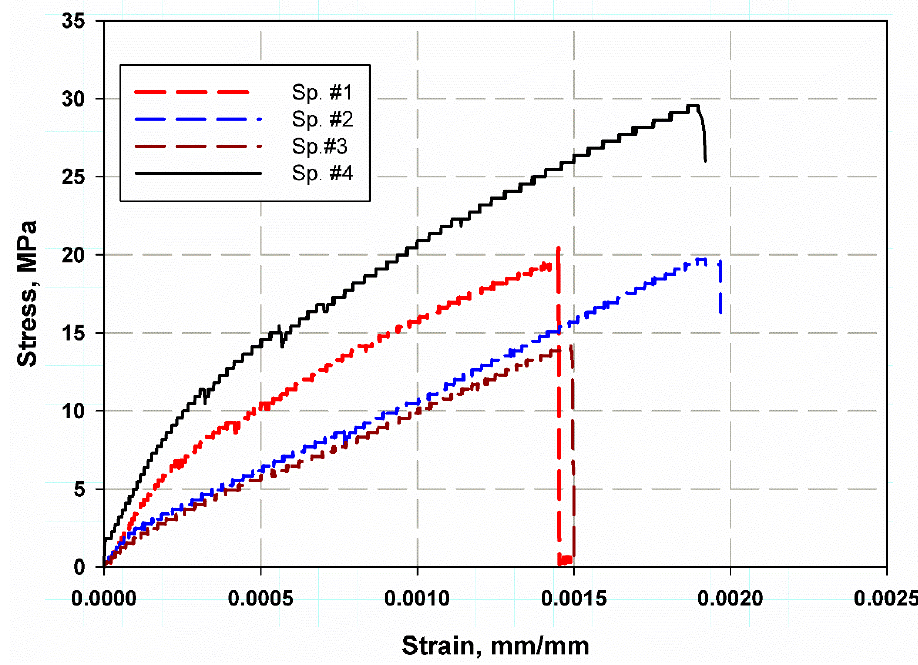
Figure 8. Stress–strain curve for the tension of GRP pipe material.